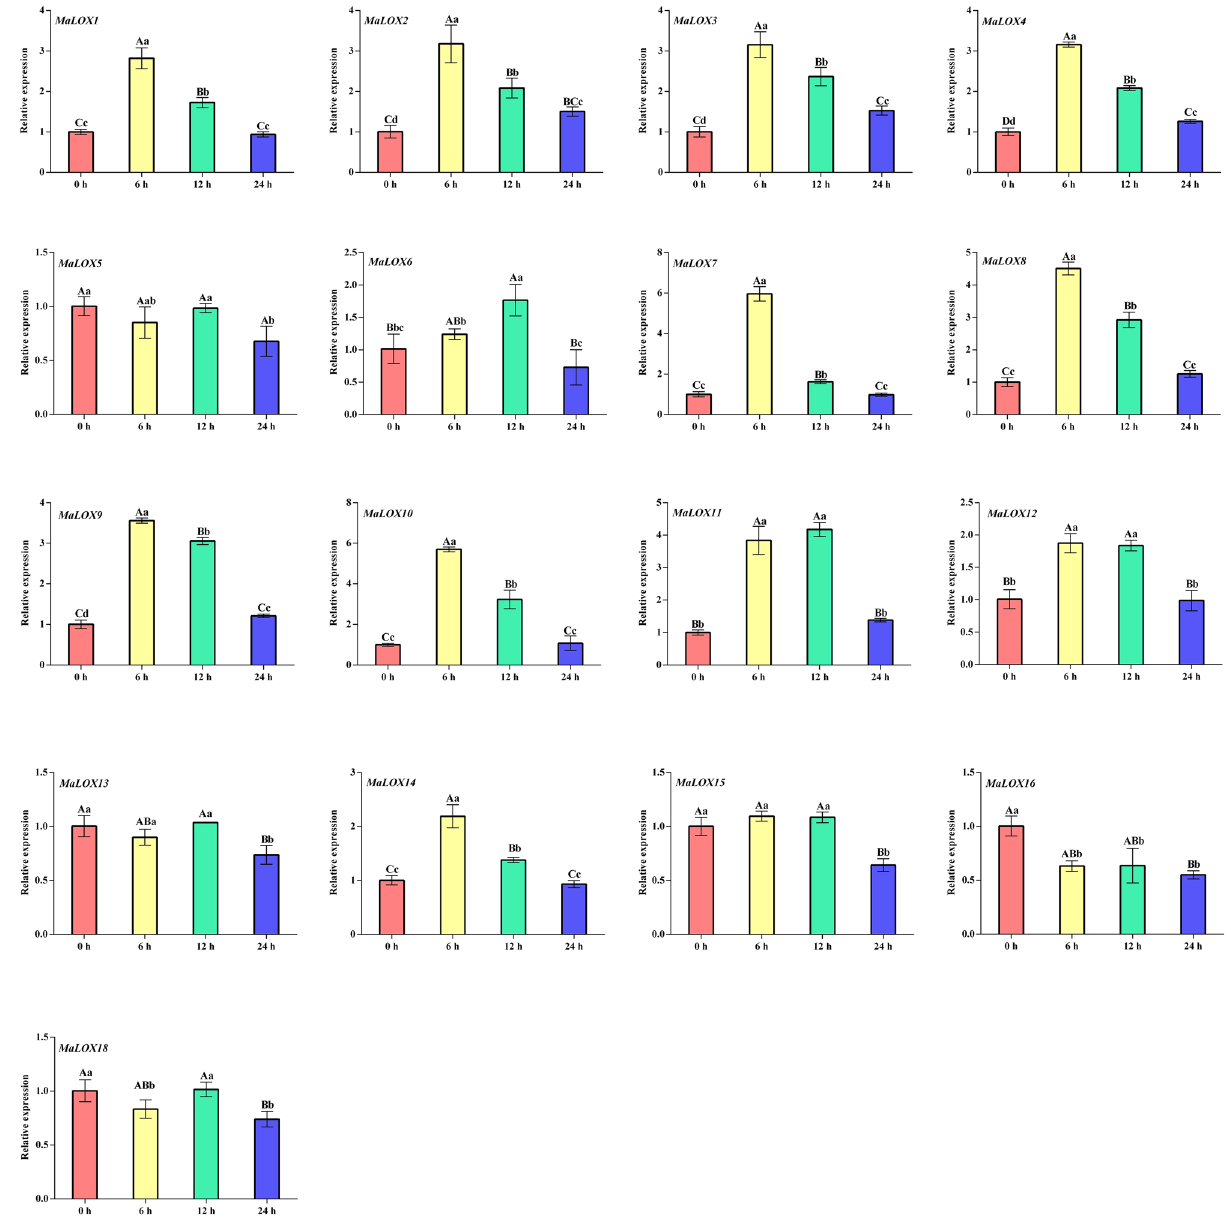
Figure 10. Expression analysis result of MaLOX genes under MeJA treatment. Uppercase and lowercase letters are used to indicate significantly differences at P < 0.01 and 0.05,